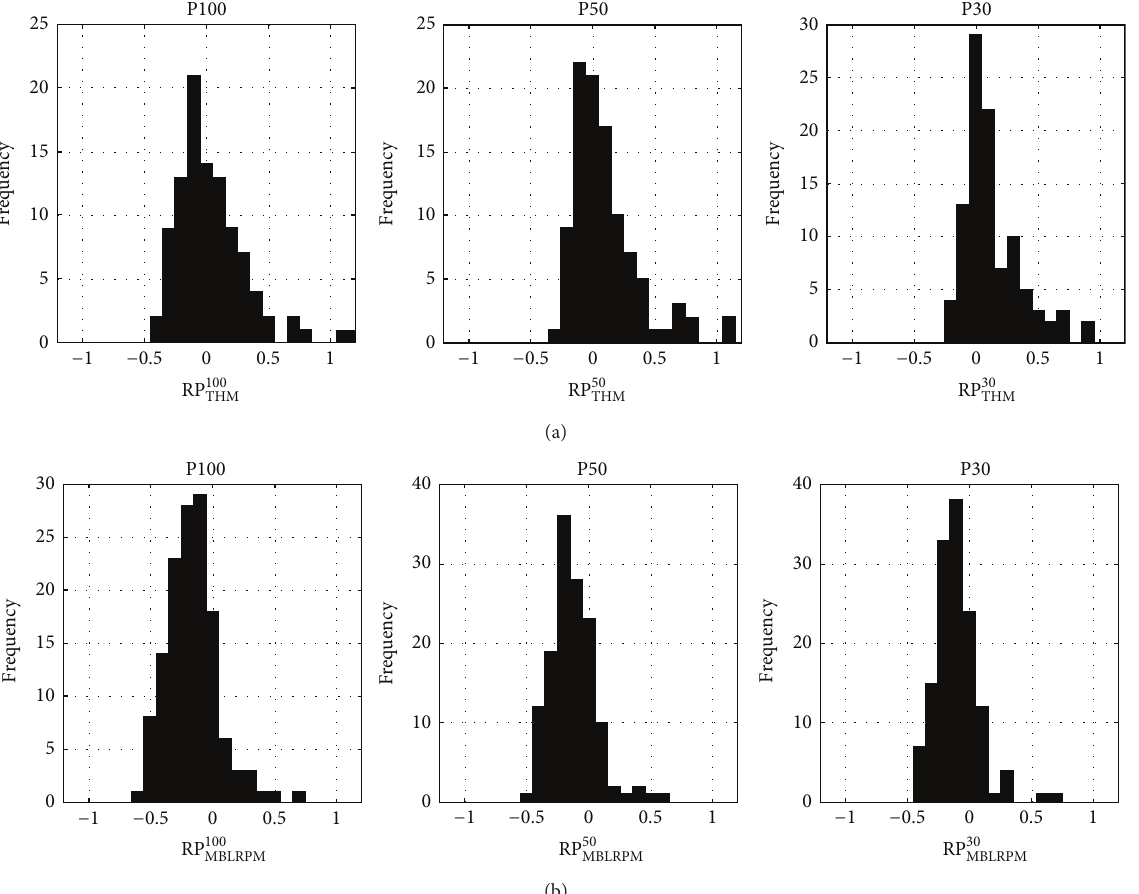
Figure12:Histogramoftheresidualofthedesignprecipitationwithdurationof1hour(RP 100 ,RP 50 ,andRP 30 )forTHM(a)andtheMBLRPM